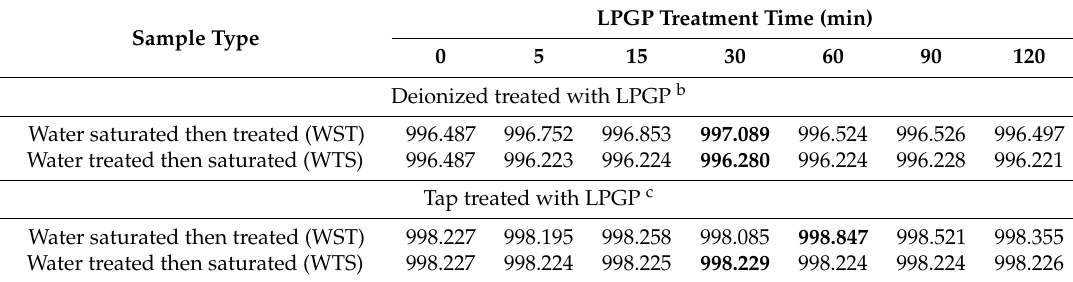
Table 3. Density (g / dm 3 ) a of water treated under oxygen with LPGP.